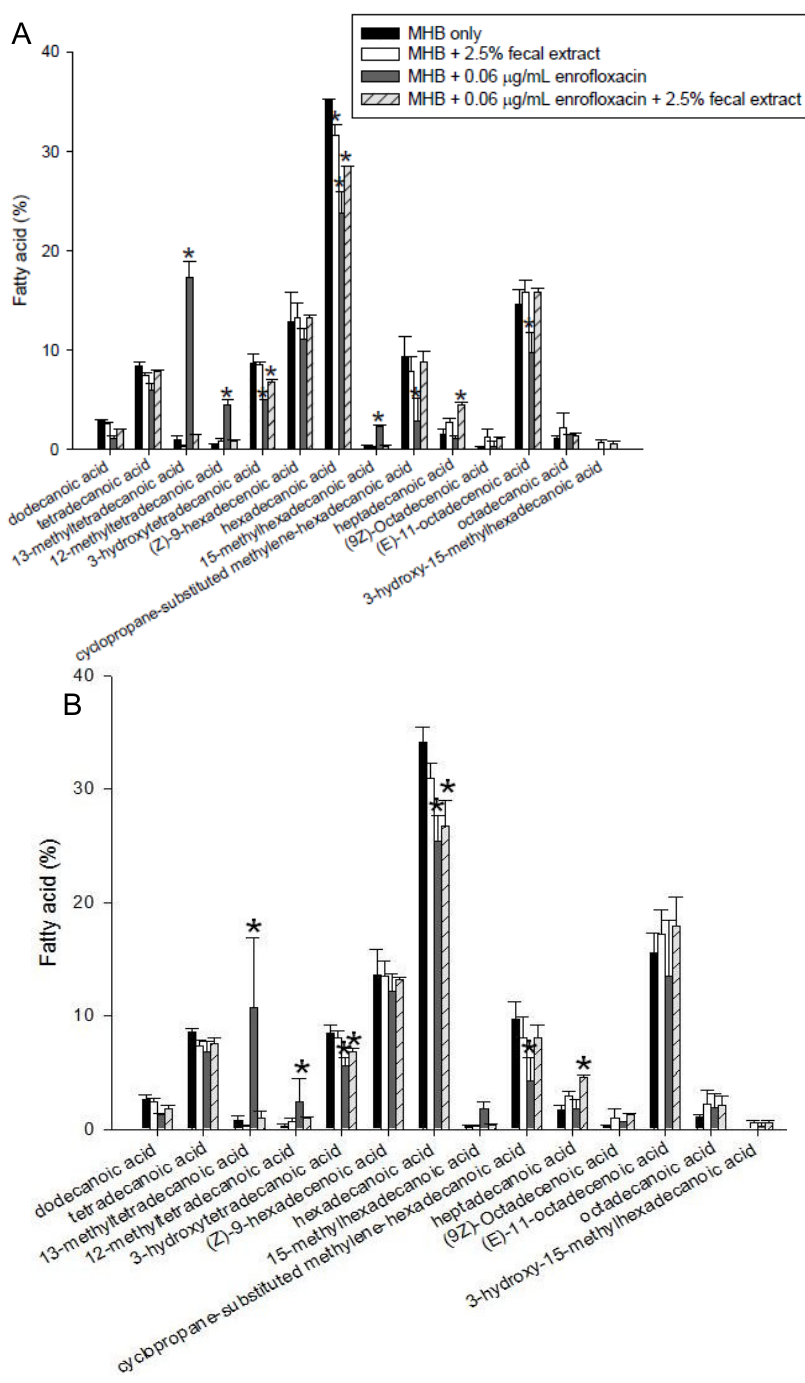
Figure 6. Fatty acid composition of lipids of S. enterica ( A ) and L. monocytogenes ( B ) grown with and without 0.06  g/mL enrofloxacin in MHB with and without 2.5% fecal extract. The experiments were repeated three times using one human fecal sample and the figure shows the typical results. * Indicates statistically significant differences from control ( p <